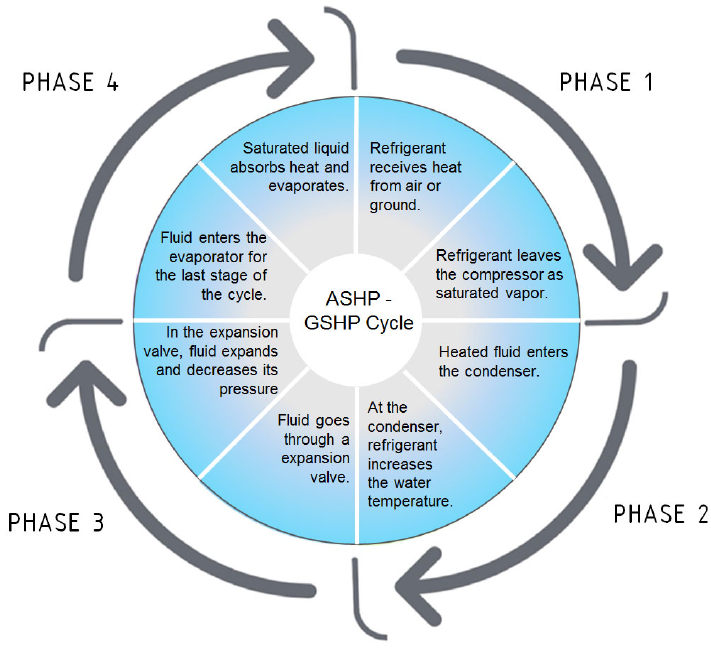
Figure 2. Schematic view of the ASHP and GSHP systems. Table 1. Main properties of the refrigerants considered in this research